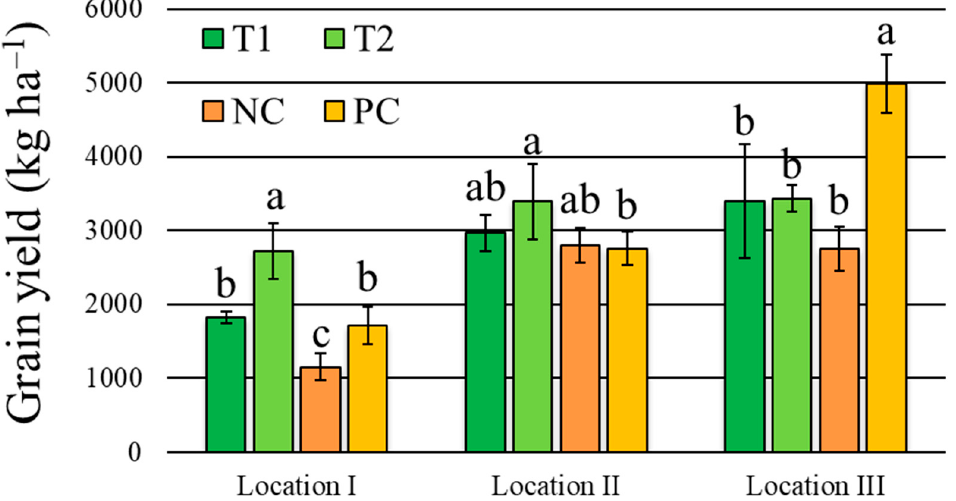
Figure 5. ‘Location × treatment’ interaction derived from two-way analysis of variance (ANOVA) on durum wheat grain yield. Bars represent the standard deviations ( n = 4). Different letters indicate statistical significance at p ≤ 0.05 (Fisher’s LSD test). T1: DiS-NH 2 at a standard dosage (0.75 g m − 2 ); T2: DiS-NH 2 at a double dosage (1.5 g m − 2 ); NC: negative control (no weeding); PC: positive control (chemical weeding).